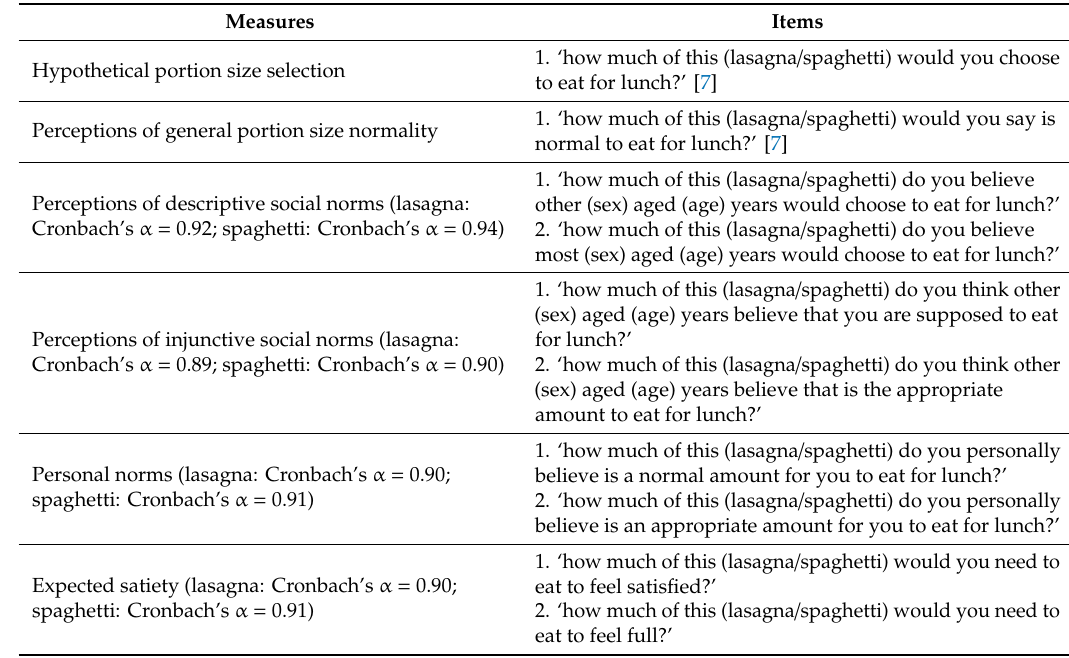
Table 1. Items measuring hypothetical portion size selection and proposed